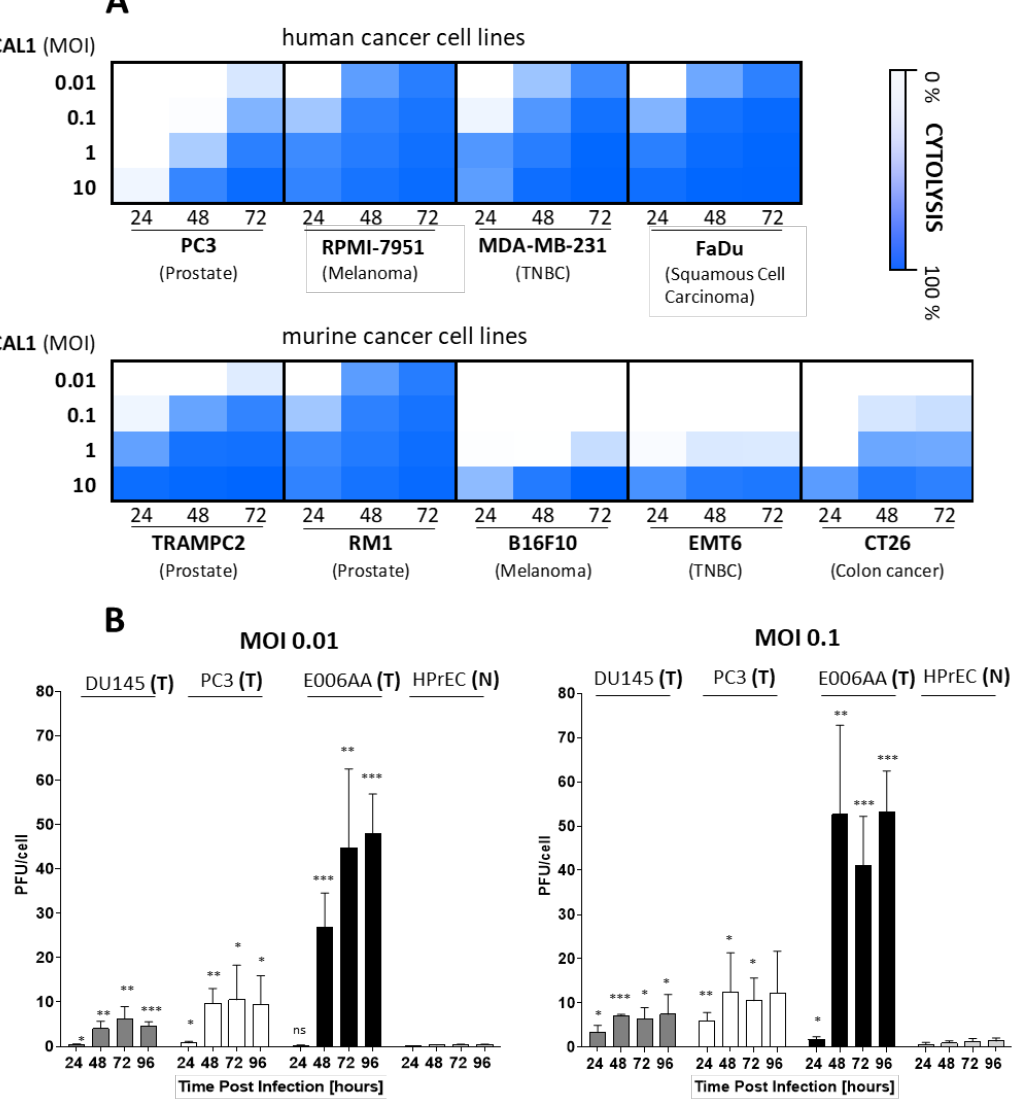
Figure 1. Cytolysis and tumor selective amplification of CAL1 vaccinia virus. ( A ) Cytolysis of human and mouse cancer cell lines post infection with CAL1 virus. Human cancer cell lines PC3 (Prostate cancer), RPMI-7951 (Melanoma), MDA-MB-231 (Triple negative breast cancer), FaDu (Head and Neck cancer/Squamous cell carcinoma) or mouse cancer cell lines TRAMPC2 (Prostate cancer), RM1 (Prostate cancer), B16F10 (Melanoma), EMT6 (Triple negative breast cancer), or CT26 (Colon Cancer) were seeded a day before and left untreated (control) or treated with CAL1 vaccinia virus at Multiplicity of Infection (MOI) of 0.01, 0.1, 1 or 10. CAL1-induced killing (cytolysis) was auto- matically analyzed using xCELLigence Real Time Cell Analysis Instrument (RTCA). The cytolytic activity at 24, 48 or 72 h was calculated as the percentage of cytolysis represented as heat map. Statistical significance was analyzed between all treated groups, 24, 48 ant 72 h, compared to control group for each individual cell line using two-way ANOVA test, * p < 0.05, ** p < 0.01, *** p < 0.001 (Table S3) ( B ) Tumor selective amplification of CAL1 Vaccinia virus. The human prostate cancer- derived cancer cell lines PC3, DU145, and E006AA, and the human primary prostate epithelial cell line HPrEC, were synchronously infected at a MOI of 0.01 or 0.1 with CAL1. Samples were collected at 24-, 48-, 72-, and 96-h post-infection and virus amplification was analyzed by plaque assay. T = human cancer cell line. N = normal human primary prostate epithelial cell line. Viral amplification at every time point for each tumor cell type was compared with HPrEC cells using unpaired 2-tailed Student’s t test (* p < 0.05, ** p < 0.01, *** p < 0.001) (n = 3), ns: no